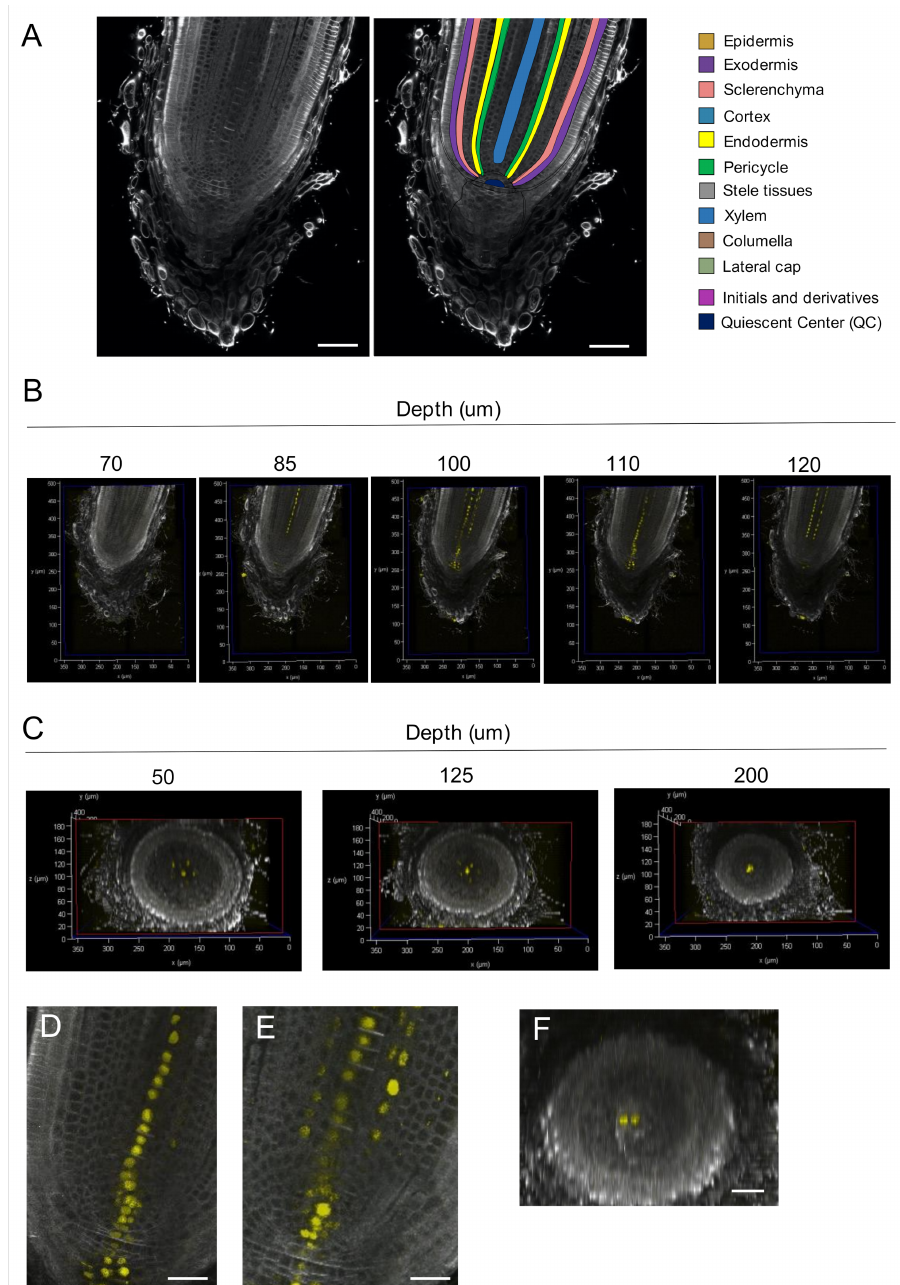
Figure 5. ( A ) Left: representative longitudinal section of a 3D-reconstructed rice root tip. Right: schematic presentation of the 3D-reconstructed root tip shown in the left panel. ( B ) Longitudinal sections of the root tip. Confocal optical sections from the reconstructed image were arranged according to the depth from the first section of serial imaging. ( C ) Transverse sections of the 3D- reconstructed root tip. The transverse sections were arranged according to the depth from the top of the reconstructed image. ( D , E ) Enlarged view of longitudinal sections with a central row of Venus-expressing cells connected to the QC ( D ) and with lateral rows of Venus-expressing cells that are not connected to the QC ( E ). ( F ) A transverse section across the QC. Bars; 50 µ m in ( A ) and 25 µ m in ( D – F